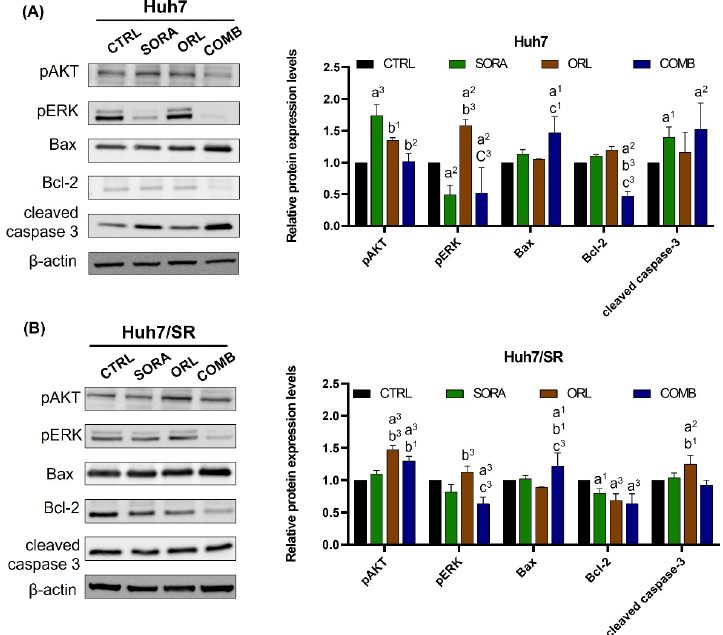
Figure 4. Effects of combination treatment of sorafenib and orlistat on proliferation and apoptosis pathways in ( A ) Huh7 and ( B ) Huh7/SR cells. Combination treatment effectively suppressed pERK and Bcl-2 expressions in Huh7 cells compared to single treatments. Decreased expression resulting from combination treatment was also seen in Huh7/SR cells but less pronounced. Additionally, com- bination treatment enhanced the BAX/Bcl-2 ratio in both cell lines. a, compared to Control; b, com- pared to Sorafenib; c, compared to Orlistat; 1 p < 0.05; 2 p < 0.01; 3 p < 0.001. Figure 5 demonstrates that combination treatment led to more marked pACC eleva- tion and FASN reduction, but a less-apparent change in ACL in both cell lines. Sorafenib increased the SCD expression in both cell lines, as shown in Figure 5. Still, the combination treatment reversed the sorafenib- and orlistat-mediated SCD elevation in both cell lines, especially in Huh7/SR cells. Besides, combination treatment elevated pAMPK expression in Huh7 cells, not observed in Huh7/SR cells.